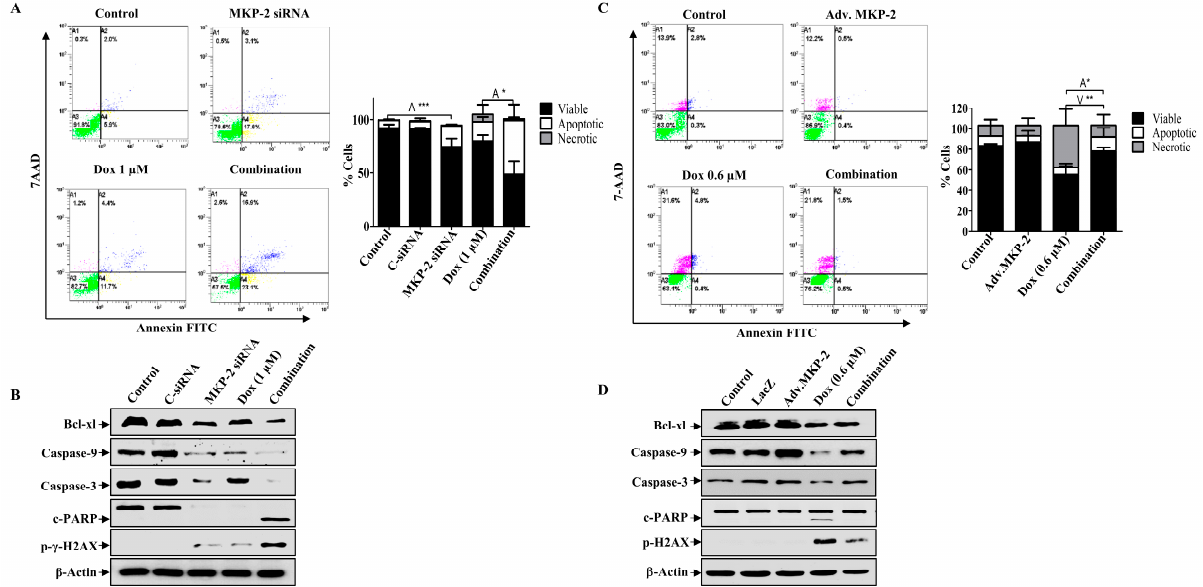
Figure 5. MKP-2 Silencing Promotes Cell Apoptosis in Breast Cancer Cells. MKP-2 was silenced from MDA-MB-231 cells or infected with Adv. MKP-2 (500 pfu/cell) for 24 h, then treated with indicated concentrations of Dox for 24 h, then ( A , C ) Apoptosis was detected by labelling cells with Annexin V-tagged FITC/7AAD and analyzing them by flowcytometry. ( B , D ) Cell lysates were prepared, separated by SDS-PAGE, and then assessed for Bcl-xl, Bax, Caspase-9, Caspase-3 c-Caspase-3, c-PARP, p - γ -H2AX, and β -Actin. Each value represents the mean ± S.E.M of three independent